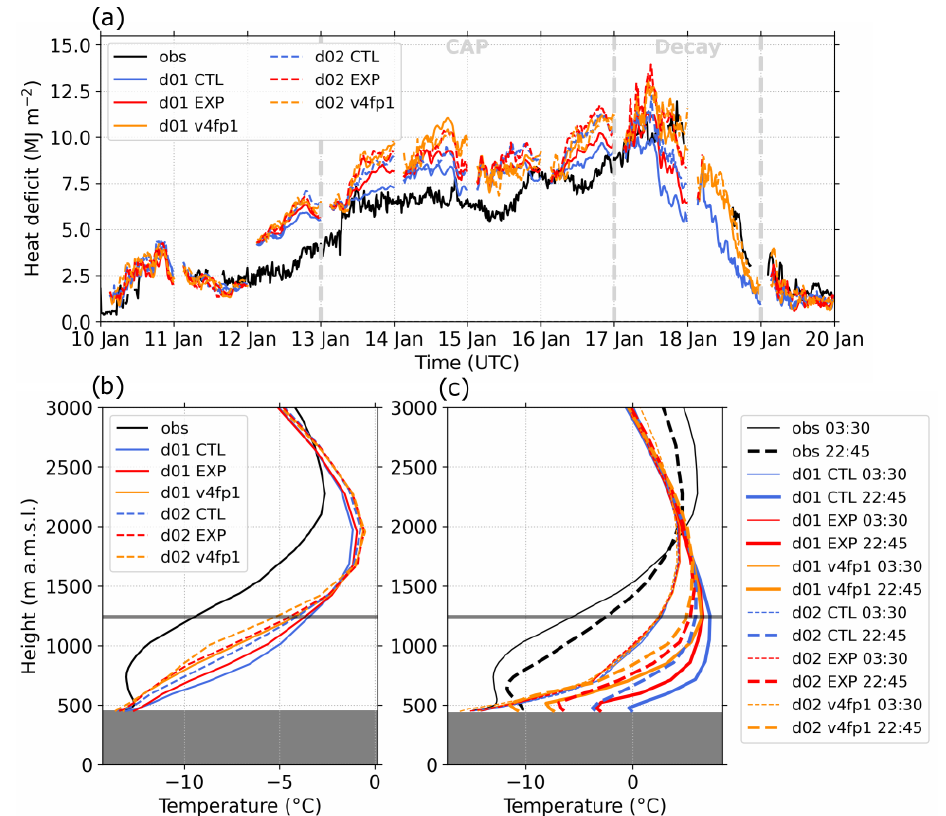
Figure 4. (a) Time series of the heat deficit (Eq. 1) and profiles of (b) temperature averaged for the CAP period (13–16 January), and (c) temperature during the Decay period at 03:30UTC (thin lines) and 22:45UTC (thick lines) on 17 January at Wasco from observations and the different model runs. The horizontal gray line indicates the mean ridge height, and dark gray shading indicates the station